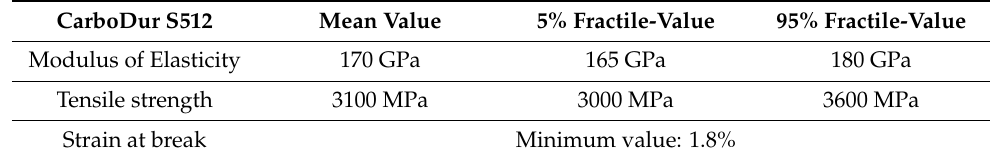
Table 2. Mechanical properties of CFRP plates